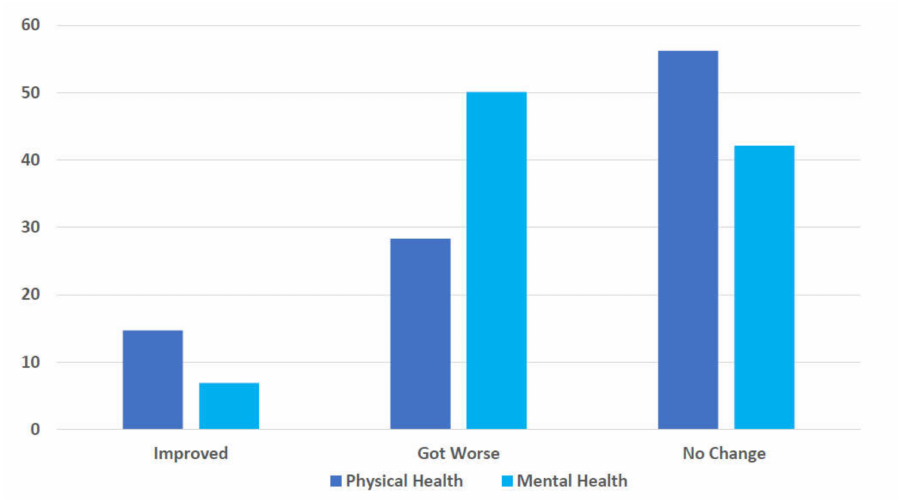
Figure 1. Percent of RDNs who perceived physical and mental health changes during the COVID-19 pandemic. ( n = 473).